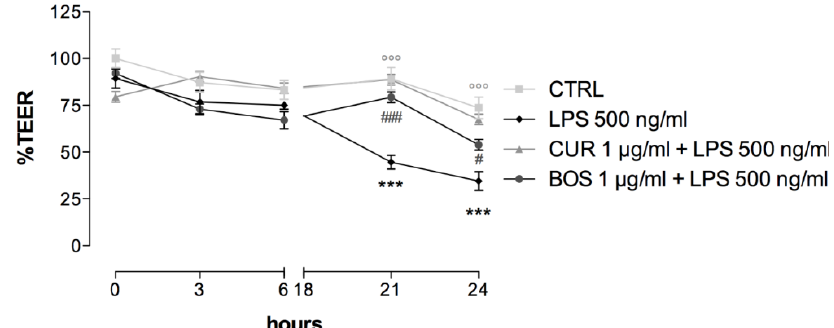
Figure 7. Trans epithelial electrical resistance (TEER) measurement in Caco-2 cells after LPS-stimulation (500 ng/mL). cells were preincubated with CUR and BOS for 24 h. *** p < 0.001 stimulus vs. control; °°° p < 0.001 CUR vs. stimulus; ### p < 0.001 BOS vs. stimulus; # p < 0.05 CUR vs. stimulus.